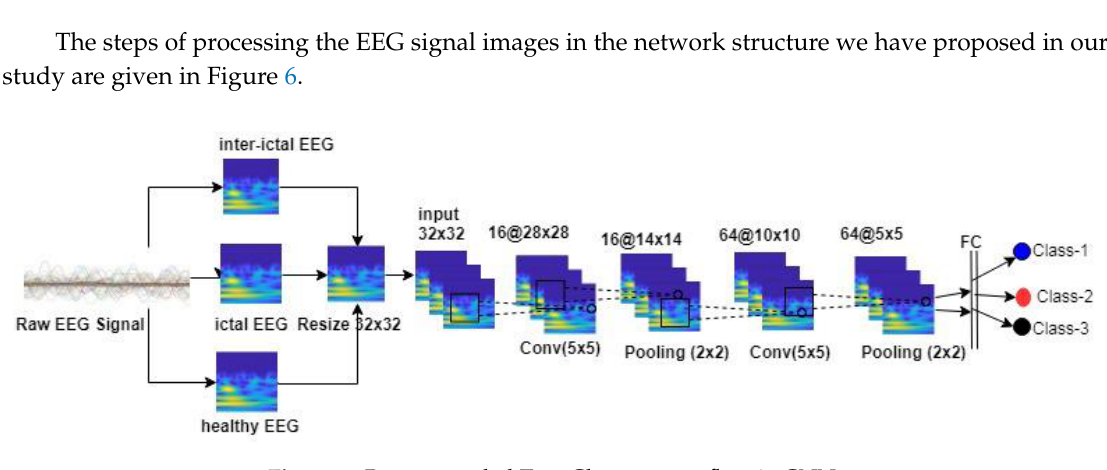
Figure 6. Recommended Two-Class process flow in CNN.